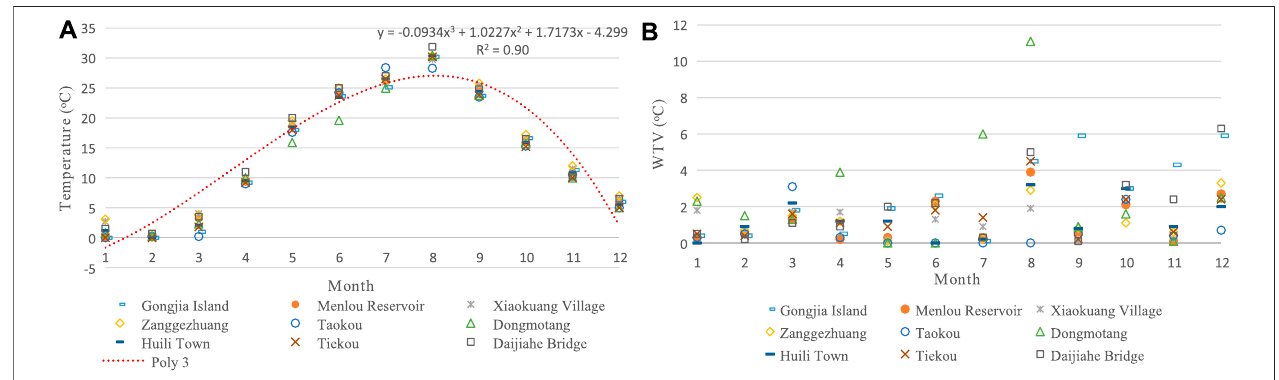
FIGURE3| WatertemperatureandwatertemperaturevariationoftheDangujiaRiverinthe2008assessmentyear: (A) monthlywatertemperatureand (B) monthly water temperature variation.